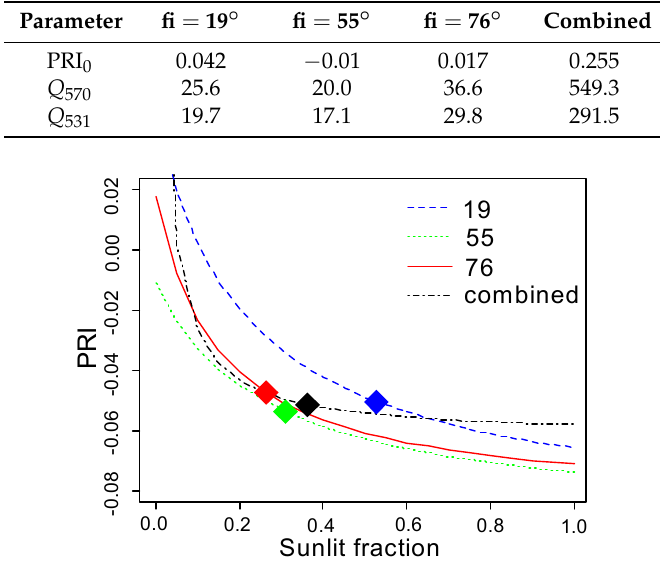
Table 6. Non-linear fit (Equation (11)) parameter estimates for β = 19 ◦ , β = 55 ◦ , β = 76 ◦ and all data combined.